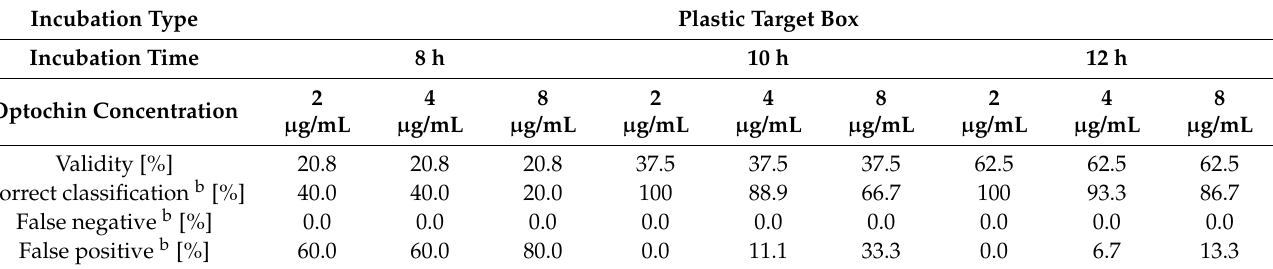
Table 3. Accuracy of the MALDI-TOF MS-based optochin susceptibility testing after short incubation a . Incubation